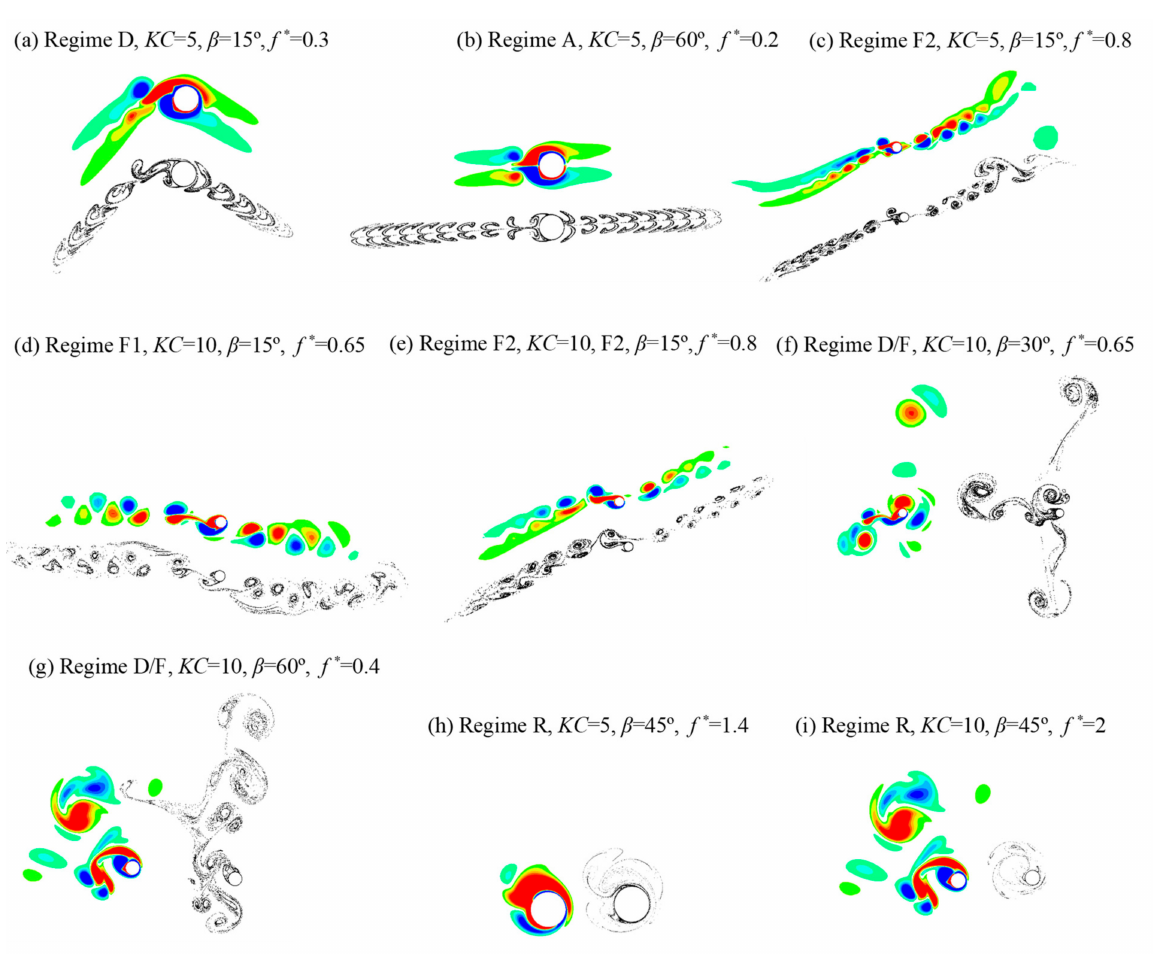
Figure 12. Streak lines and vorticity contours for typical